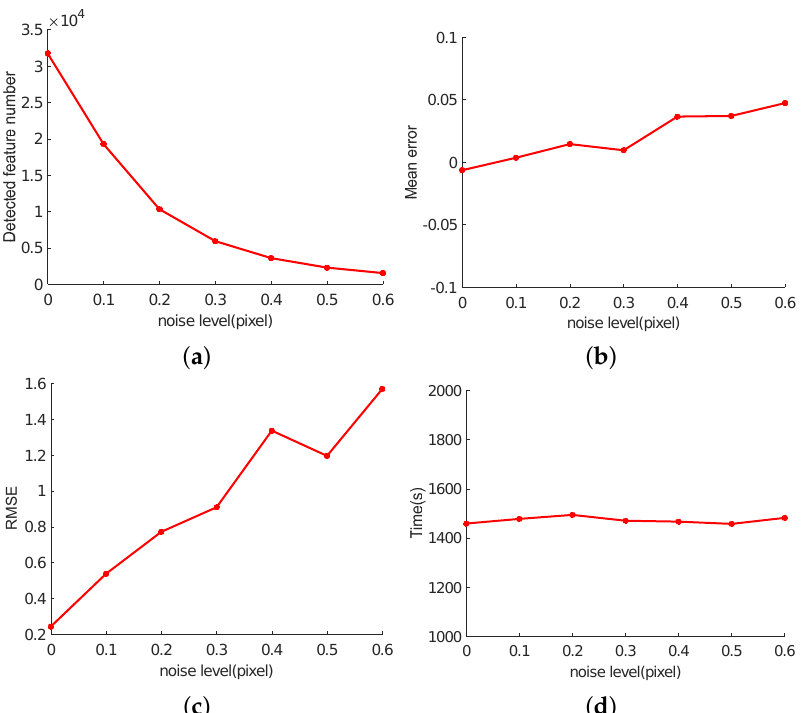
Figure 12. Detected results of proposed algorithm using 8-layer CPSFS on simulated raw images with noise. ( a ) Detected feature number during noise test. ( b ) Mean error of detected features’ plenoptic disc radius during noise test (dimensionless). ( c ) RMSE of detected features’ plenoptic disc radius during noise test (dimensionless). ( d ) Total detection time of 50 independent experiments during noise test.